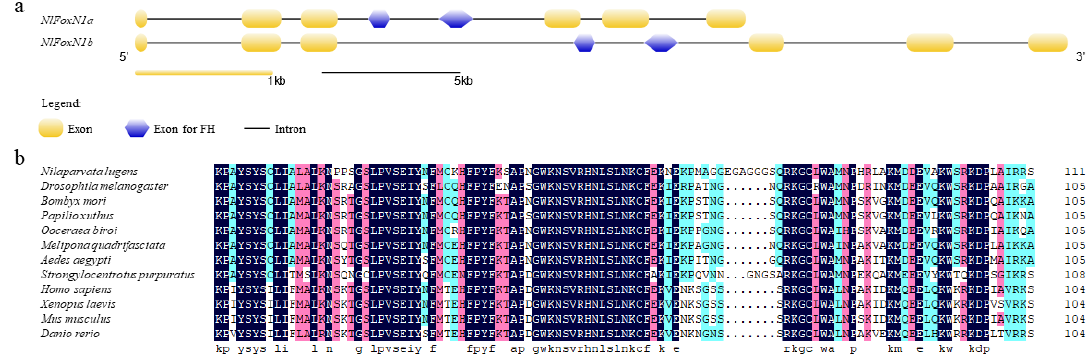
Figure 1. Sequence analysis of NlFoxN1 . ( a ) Exon-intron analysis of NlFoxN1 was carried out by GSDS2.0. ( b ) Alignment of amino acid sequences of forkhead domain (FHD) from 12 species was carried out by DNAMAN.